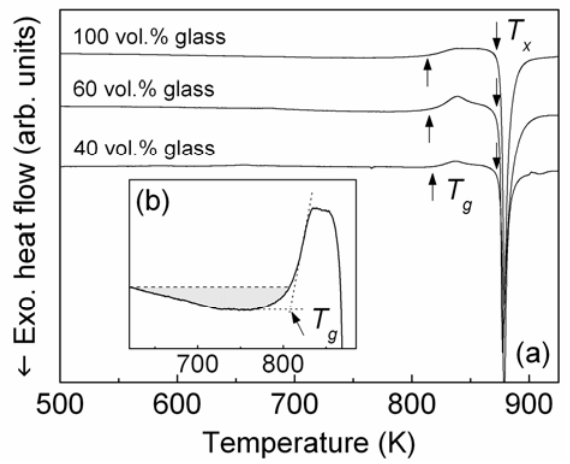
Zr Ti Si Sn 59 20 16 2 3 (shadowed area) related g